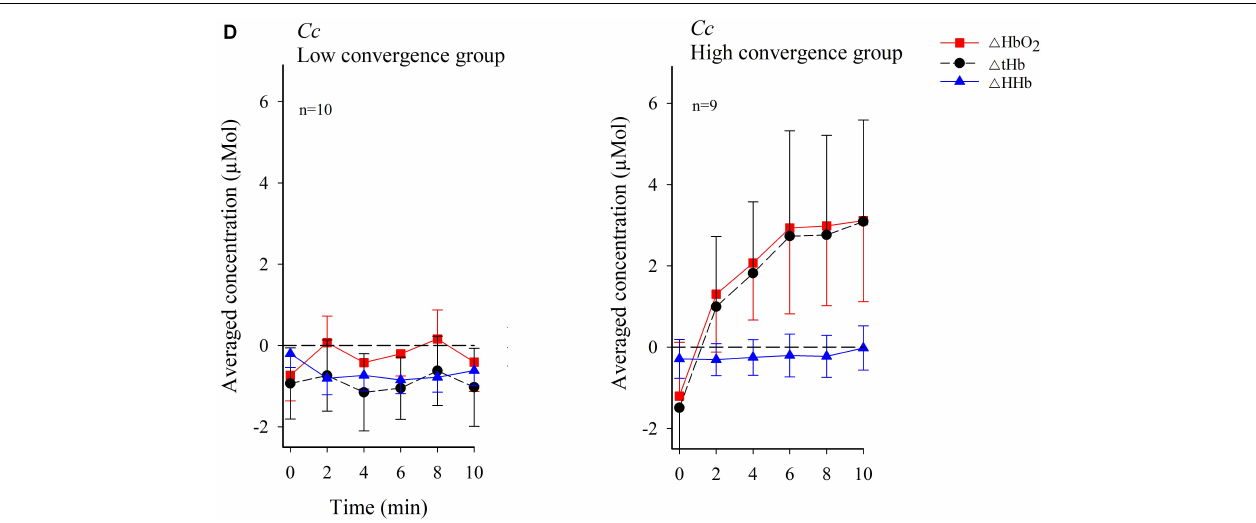
FIGURE 5 | Temporal pattern of changes in the concentration of oxygenated hemoglobin ( (cid:49) HbO 2 ) and deoxygenated hemoglobin ( (cid:49) HHb) along with variations in total hemoglobin ( (cid:49) tHb) in dlPFC across visual conditions for each participant in the low and high convergence load subgroup (figure shows mean values and standard errors). (A) Control condition Ctrl . (B) Convergence load condition Conv . (C) Cognitive control condition Cog . (D) Combined convergence and cognitive load, condition Cc . The stippled horizontal reference line denotes no change in baseline subtracted